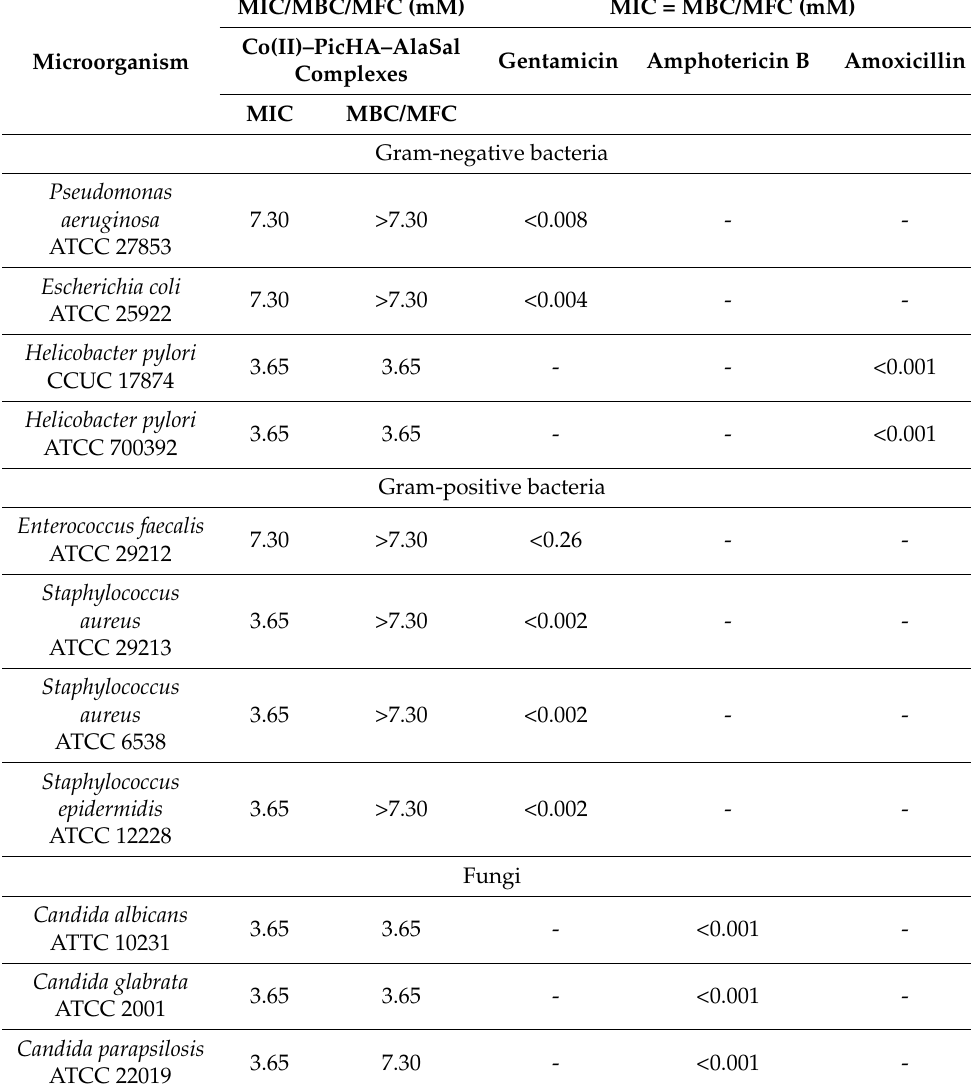
Table 2. Antimicrobial activity of tested compounds, prepared directly and stored for two weeks, shown as minimal inhibitory concentration (MIC) and minimal bactericidal concentration (MBC) or minimal fungicidal concentration